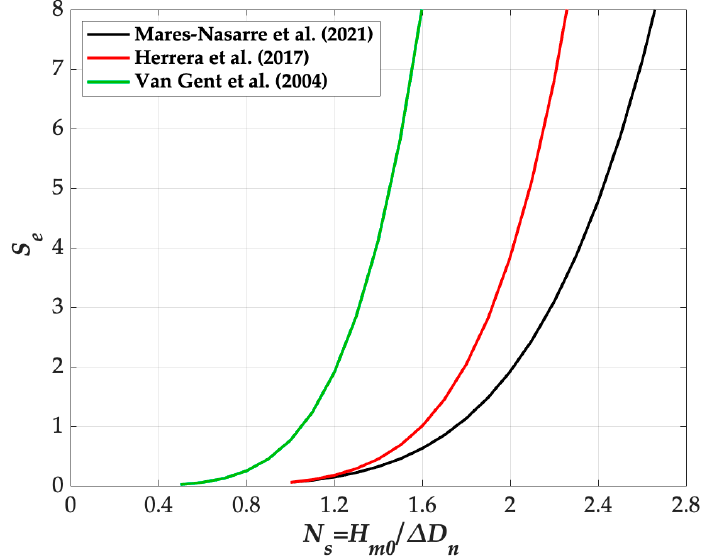
Figure 15. Comparison between Equation (14) with K 1 = 0.06 and K 2 = 5 and Equations (5) and (6) proposed by [3,4], respectively.